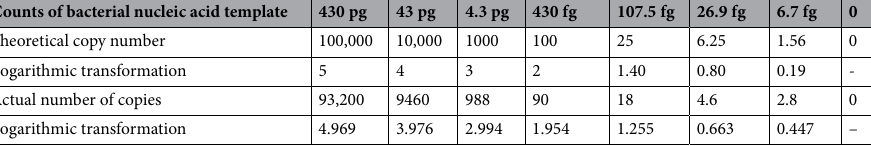
Table 1. Dynamic range of the ddPCR-based assay. Detecting the E. coli ATCC25922 nucleic acid template by ddPCR system.